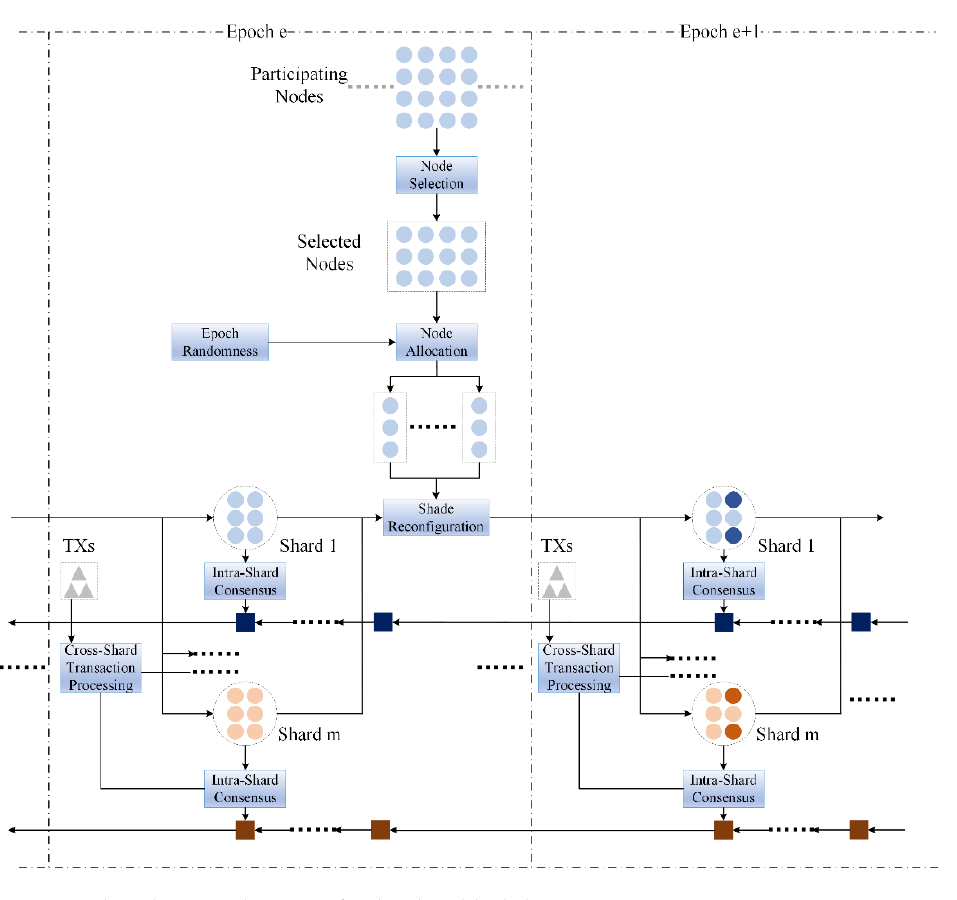
Figure 1. The schematic diagram of a sharding blockchain.